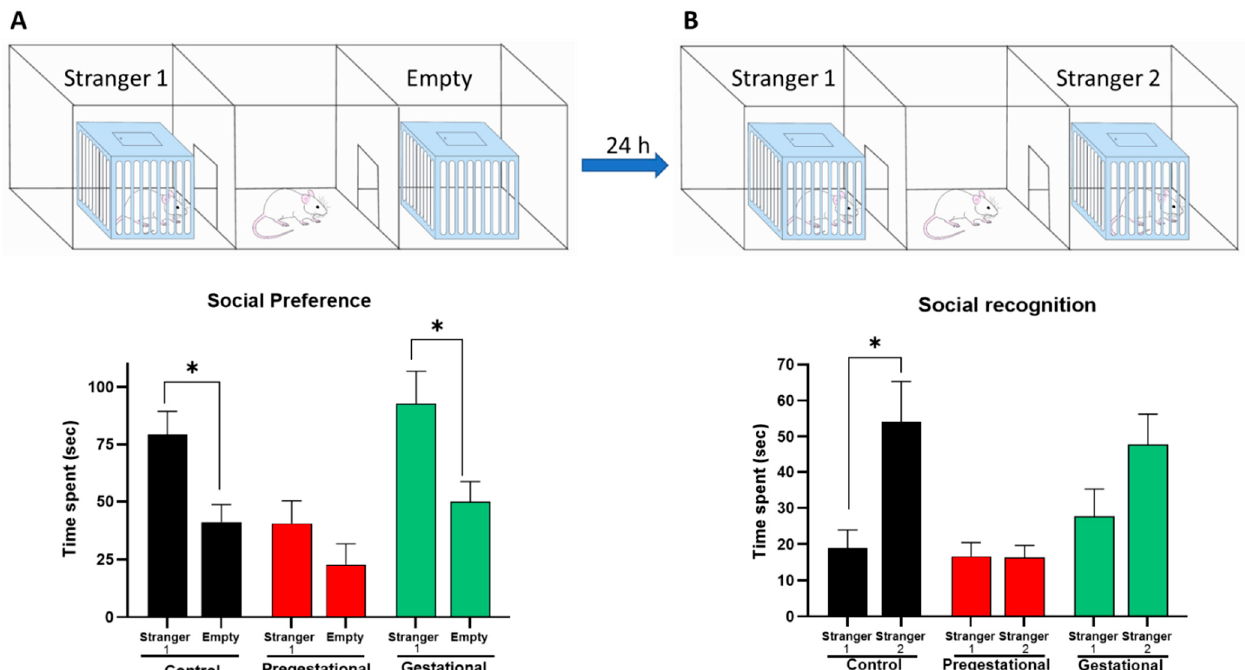
Figure 3. Effect of maternal immunization with a T. gondii lysate on social interaction of the offspring. At PND 60, social preference ( A ) and social recognition ( B ) were evaluated through the Crawley test in the progeny of mothers immunized before pregnancy (Pregestational) and mothers immunized on day 18 of gestation (Gestational). Data represent mean ± S.E.M. of time spent with the different stimuli of 12–15 animals per group. * p < 0.05 Mann-Whitney U test.